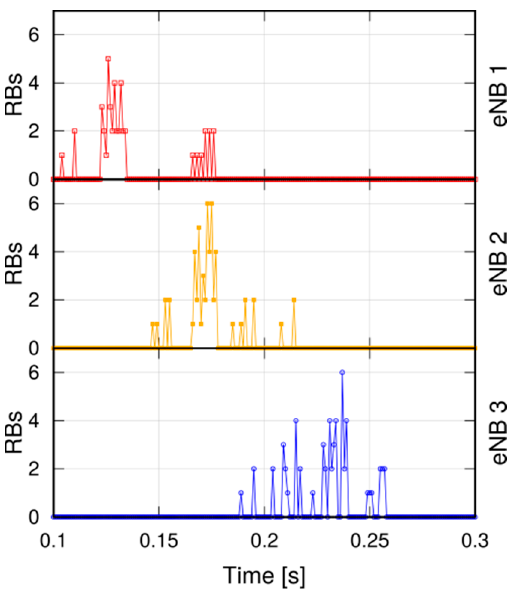
Figure 10. RB (Resource Block) allocation at different eNBs over time.